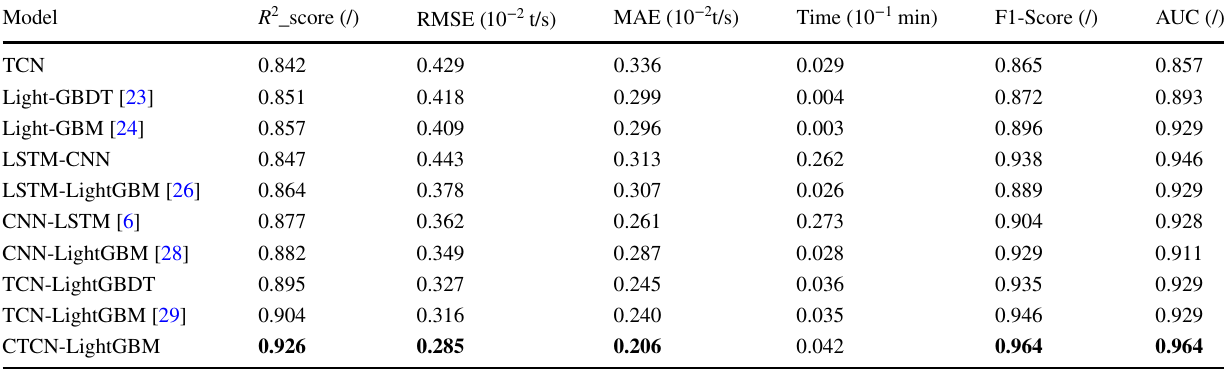
Table 14 The prediction and classification results of all models for the chute flow adjustment